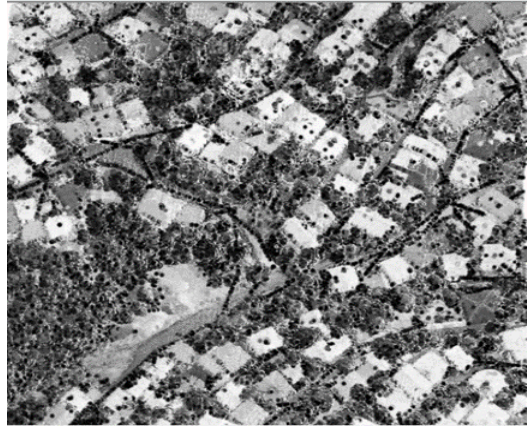
Figure 4: Airborne LIDAR points cloud.